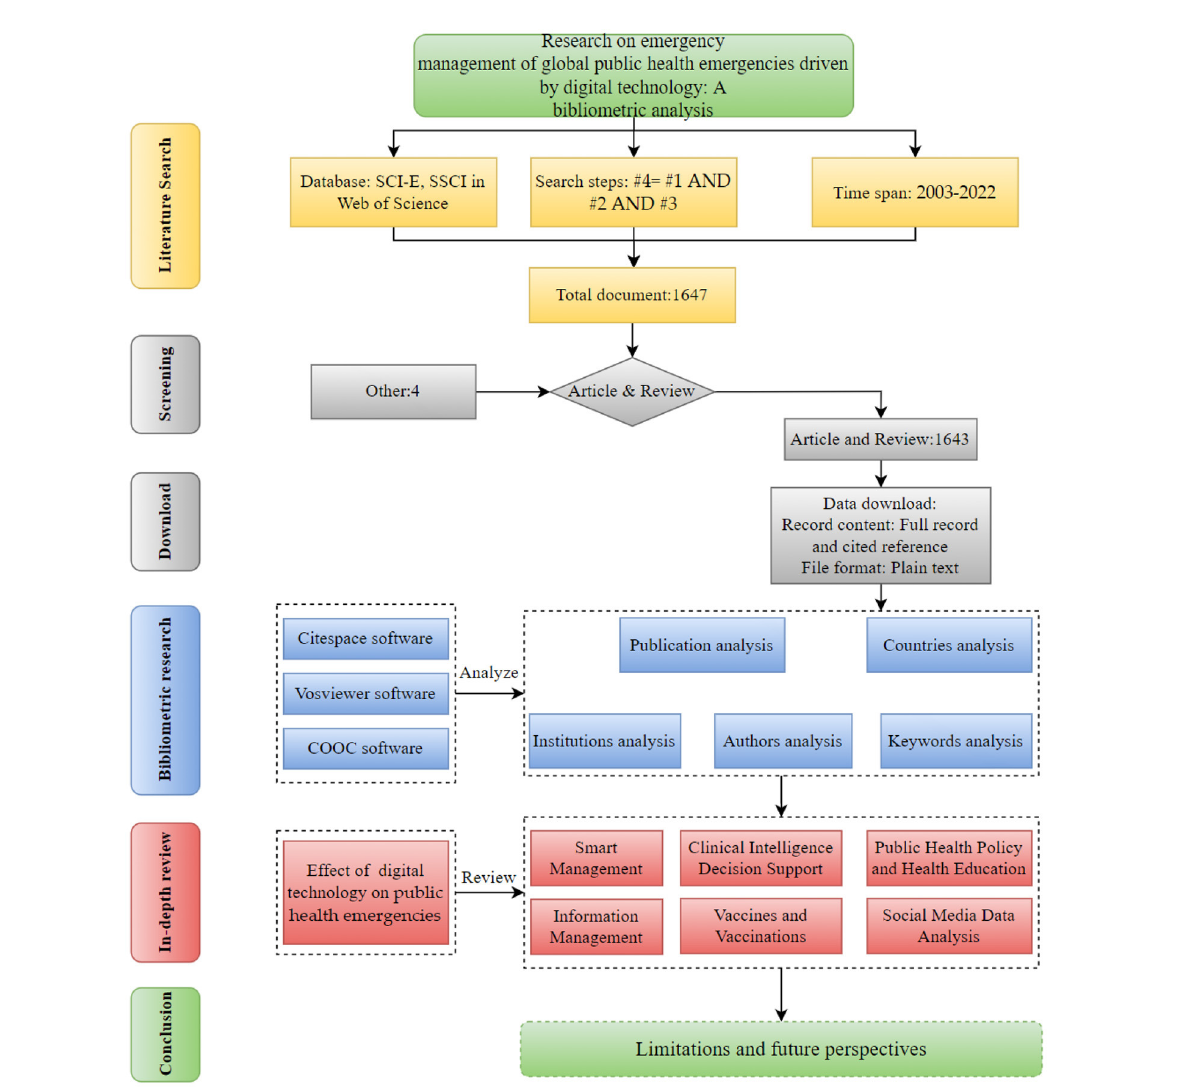
FIGURE1 The structural flow diagram. #1 = {TS = [(“digital techn*” OR “digitiz” OR “big data” OR “data-driven” OR “data driv*” “cloud comput*” OR “internet of thing*” OR “IOT” OR “blockchain” OR “AI” OR “artificial intelligen*” OR “computer vision” OR “machine vision” OR “machine learning” OR “neural network” OR “bayes” OR “supervis* learn*” OR “reinforc*” OR “Support Vector Machine*” OR “classification trees” OR “random forest” OR “Gaussian process” OR “decision tree” OR “algorith” OR “deep learning” OR “boost*” OR “natural language process“ OR “text mining” OR “text* analysis” OR “text data mining”)]}; #2 = TS = (”emergenc*“ OR sudden) AND (“public health” OR “2019-nCOV” OR “2019 novel coronaviru*” OR “2019 novel- Cov” OR “COVID-19*” OR “SARS-CoV-2”) OR (“severe acute respiratory syndrome” OR “SARS-coronavirus” OR “SARS-Cov“) OR (“H1N1 influenza” “swine flu influenza” OR “influenza A H1N1” OR “S-OIV” OR “swin-origin influenza”) OR (“Middle East respiratory syndrome” OR “MERS-CoV” OR “MERS-coronavirus”) OR (“EBHF” OR “Ebola hemorrhagic fever” OR “Ebola virus disease” OR “Ebola epidemic” OR “Ebola virus infection”); #3 = [TS = (manage*or govern* or control* or warn* or measure* or guid* or lead* or conduct* or response* or regulat* or strategie* or decision* or predict* or “deal with” or countermeasure* or coping*)]; #4 = #1 AND #2 AND #3; * represents any group of characters, including null characters. “digital techn*” denotes digital technology, digital techniques, and other quotation marks with the same